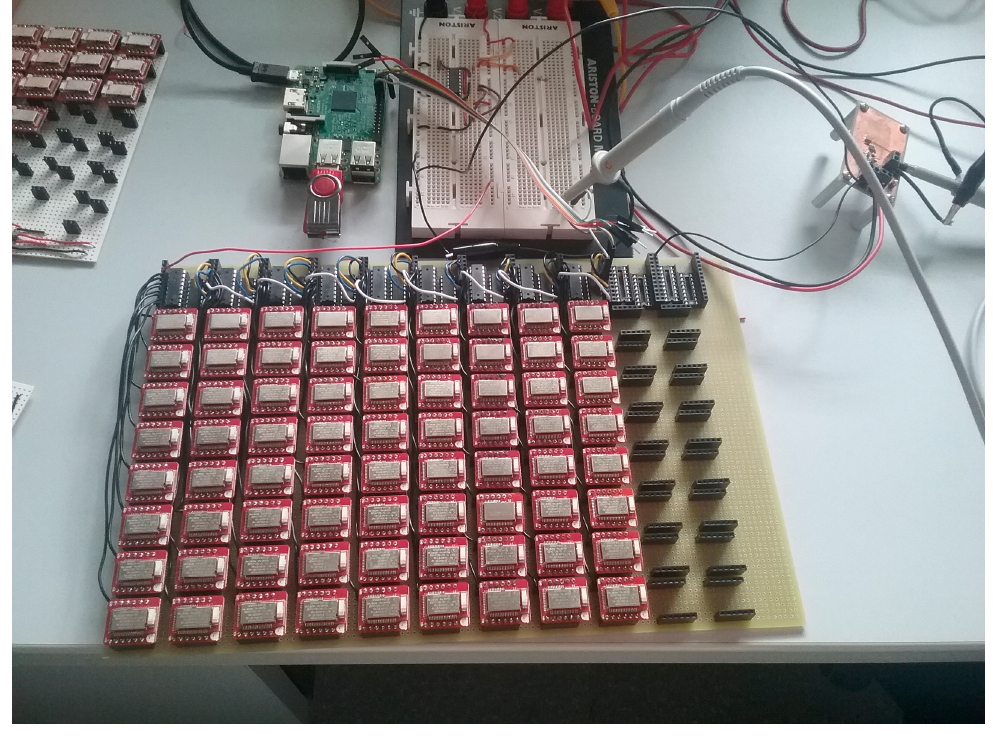
Figure 7. Test-bed setup.